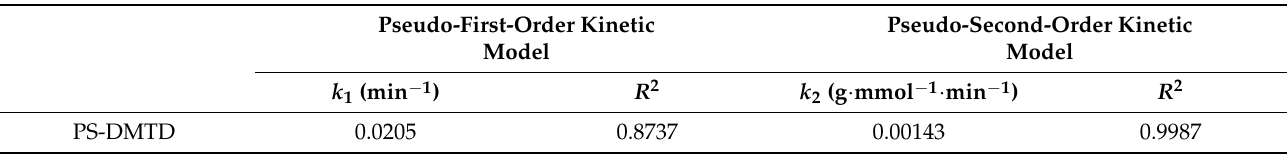
Table 2. Kinetic data of adsorbed Pd (II).